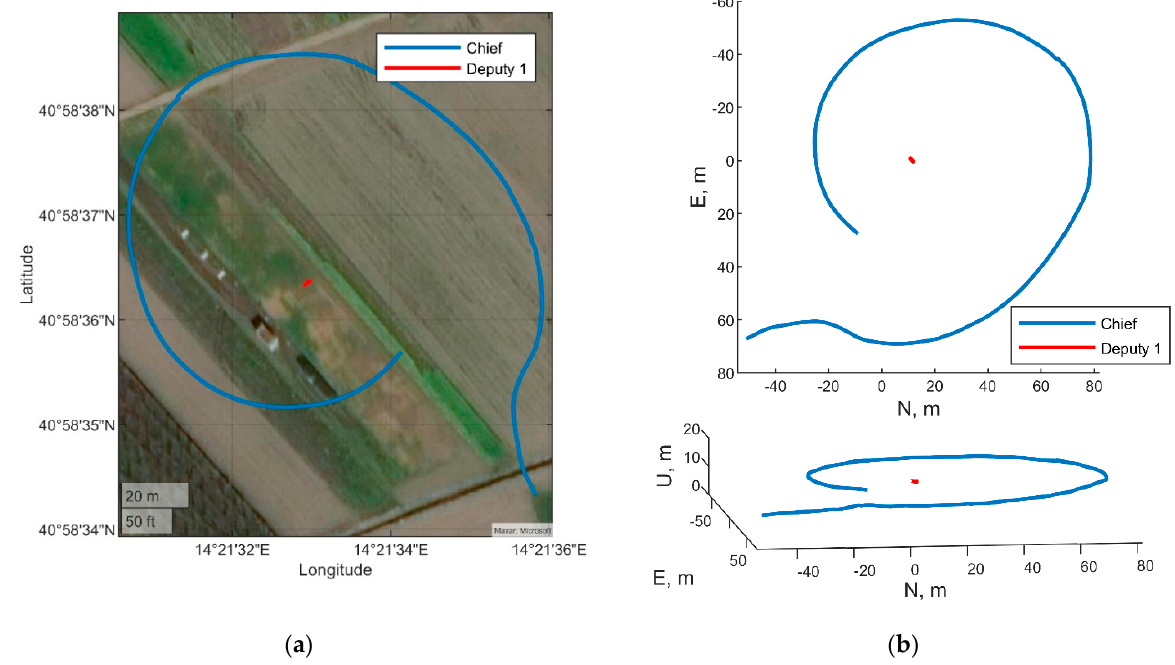
Figure 23. Path of the chief and the deputy. One deputy case: ( a ) Longitude, latitude coordinates, ( b ) ENU coordinates top view and 3D view.